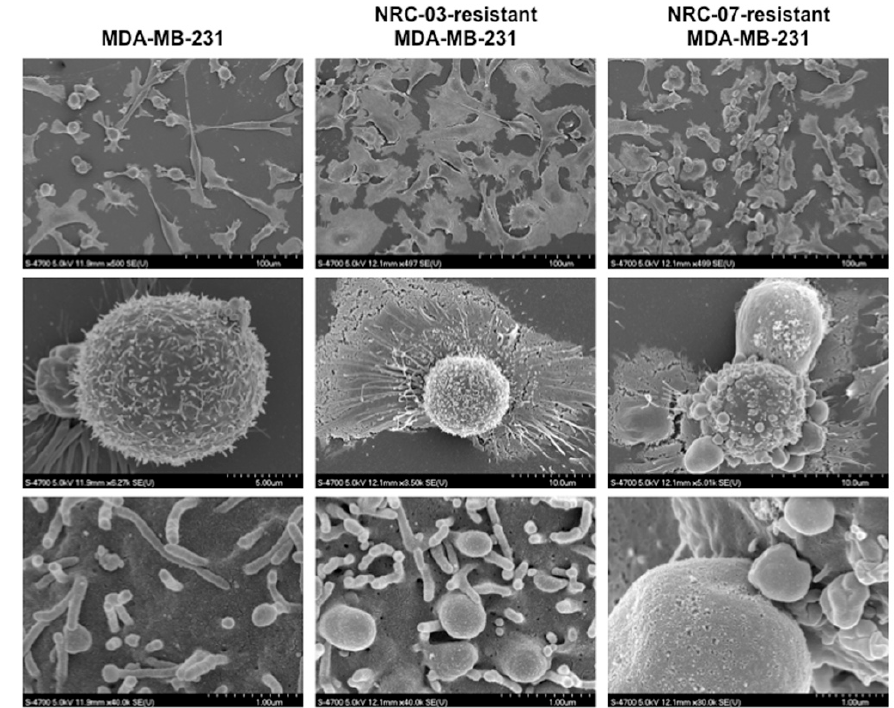
Figure 4. NRC-03-resistant and NRC-07-resistant breast cancer cells are visually distinct from parental cells. Parental MDA-MB-231 cells, NRC-03-resistant MDA-MB-231 cells, and NRC-07-resistant MDA-MB-231 cells were grown overnight on circular coverslips. Cellular ultrastructure was visualized by scanning electron microscopy. Data shown are from a representative experiment (n = 2).